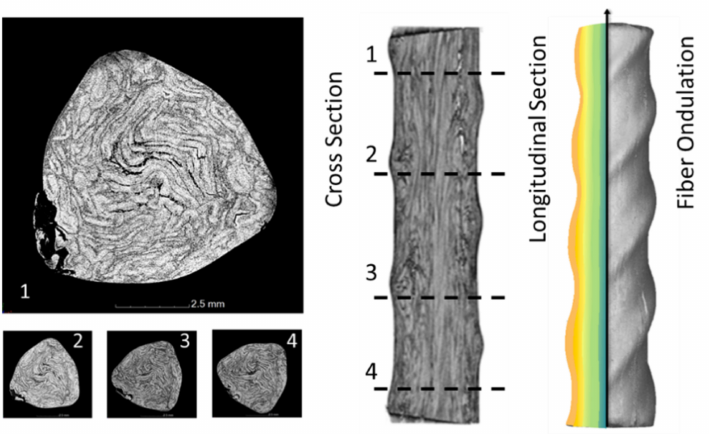
Figure 4. Computed tomography pictures to evaluate the axial and transverse fibre orientation in helix